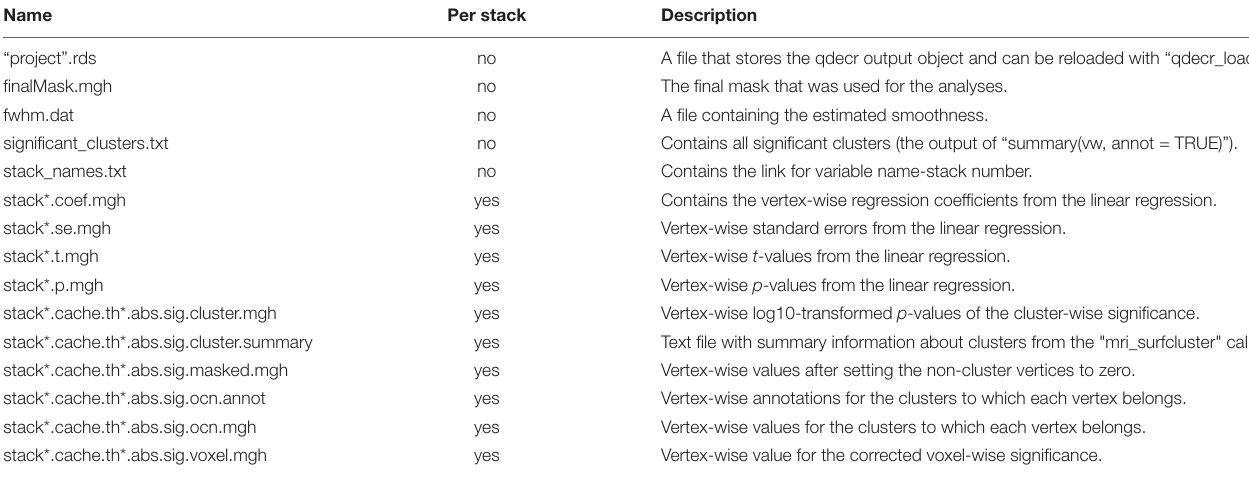
TABLE 1 | Overview of the output